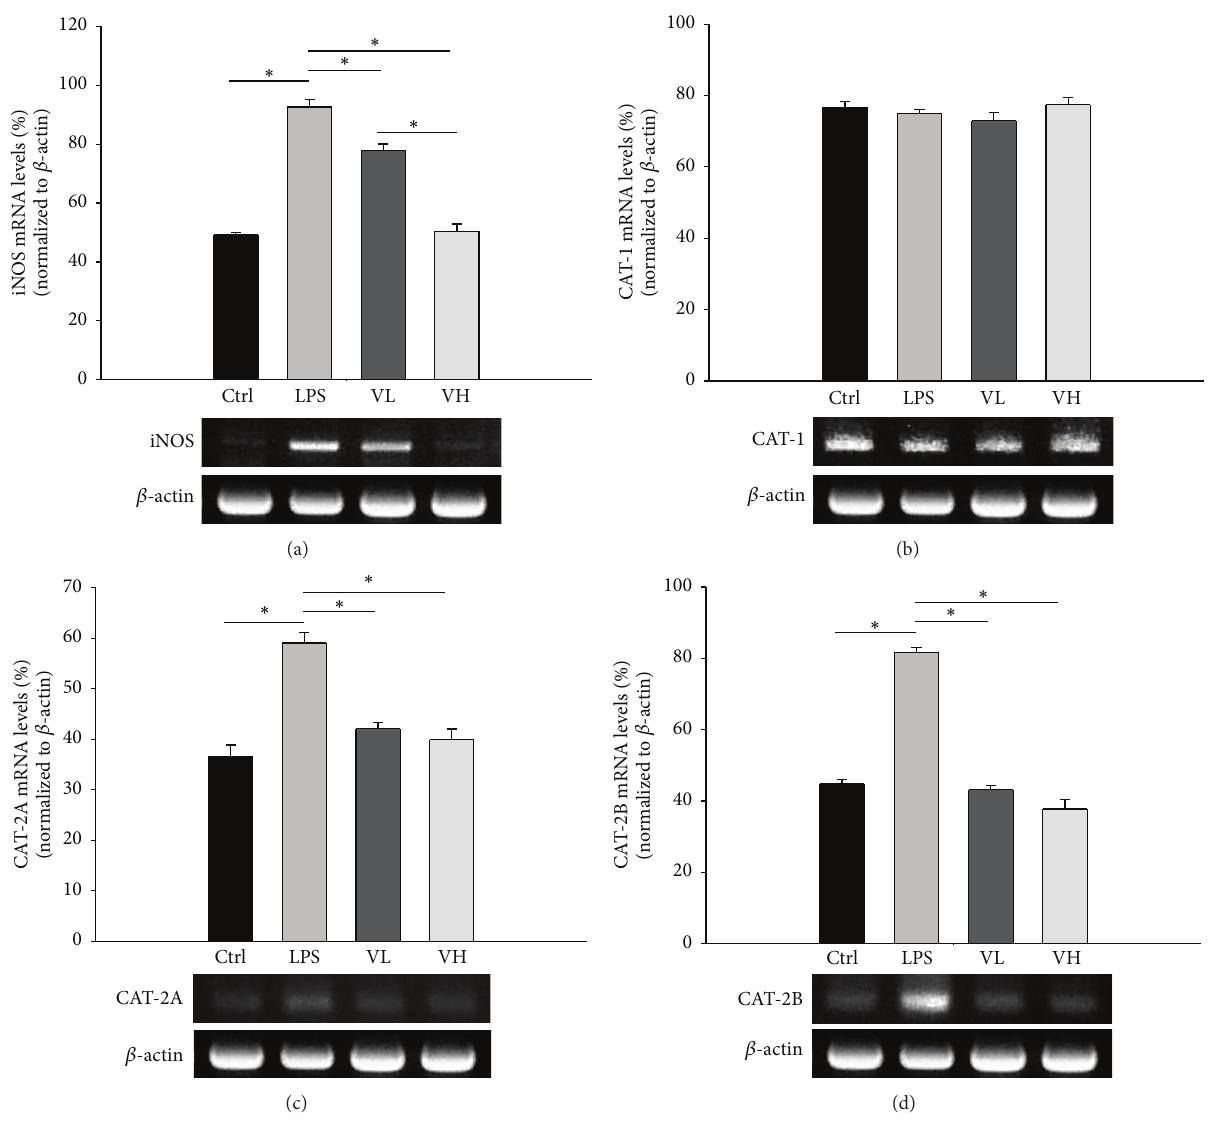
Figure 4: Expression of mRNA of CAT-1, CAT-2A, CAT-2B, and iNOS in ICBs with semiquantitative RT-PCR. The RNA was isolated under control conditions (Ctrl), in rats treated with LPS (LPS), and rats pretreated with low-dose bortezomib (VL) or high-dose bortezomib (VH). LPS induced the expression of iNOS, CAT-2A, and CAT-2B mRNA in the ICBs of EIU rats. Pretreatment with bortezomib decreased their expression (a, c, and d). There were no significant differences in CAT-1 mRNA levels among the four groups (b). The symbol “ ∗ ” indicates statistical